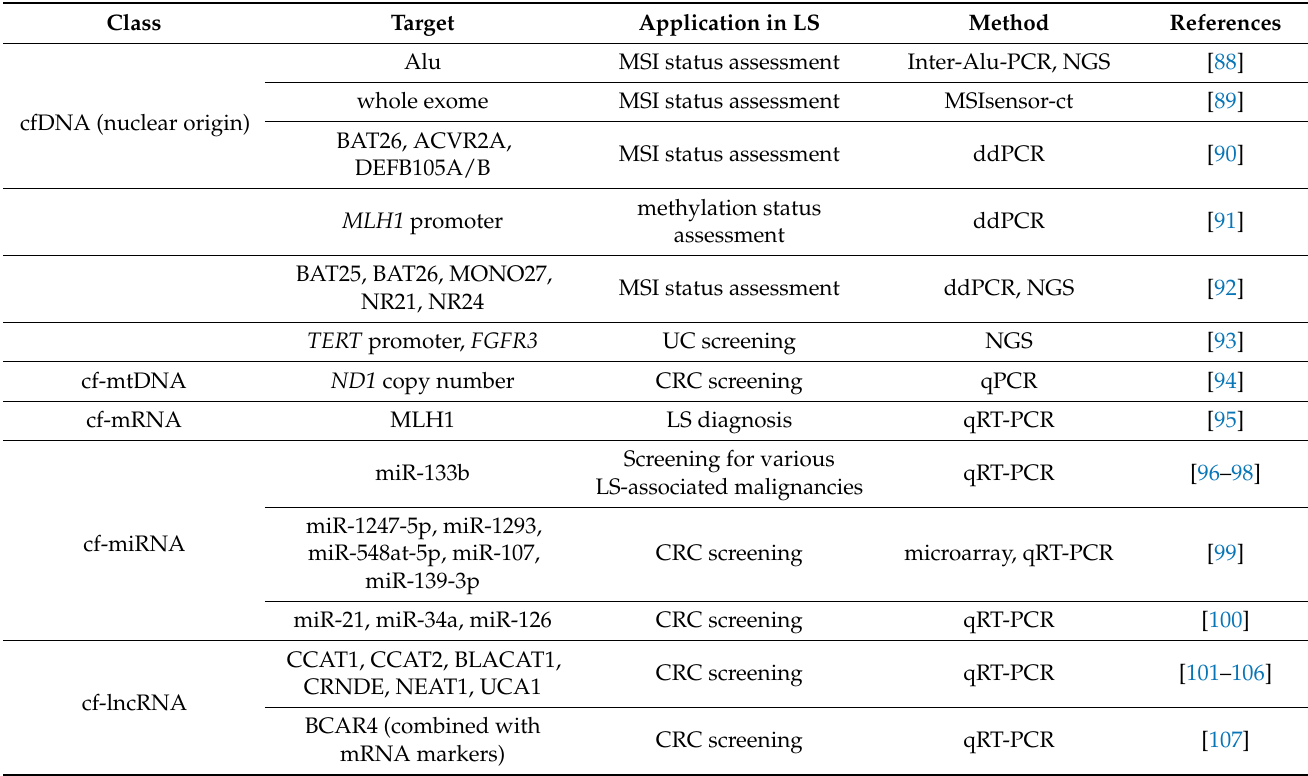
Figure 1. Blood-based liquid biopsy as a reservoir of circulating nucleic acid biomarkers. Analysis of peripheral blood allows the study of intra- and inter-tumour heterogeneity via analysis of cfNAs. As soon as possible after collection, whole blood should be separated by centrifugation to obtain the following fractions: (i) upper plasma layer (yellow), (ii) intermediate buffy coat (white), and (iii) bottom layer of erythrocytes (red). (Created with BioRender.com). Table 2. Confirmed circulating nucleic acid biomarkers obtained from liquid biopsy, applicable in lynch